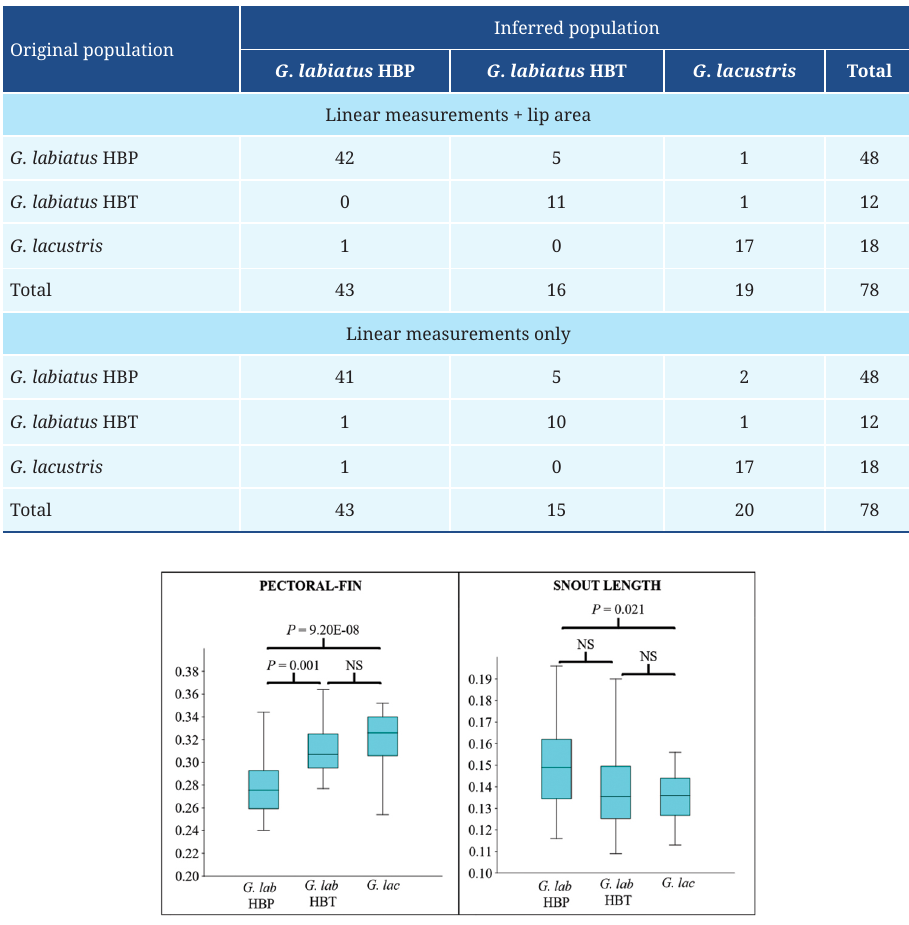
FIGURE 7 | Kruskal-Wallis box-plot and test for the length of the pectoral-fin (Hc = 32.18, P = 1.03E-8) and the snout length (Hc = 8.47, P = 0.014). The significance values for the peer-to-peer post-hoc tests are presented directly in the figure. G. lab = Gymnogeophagus labiatus , G. lac = G. lacustris .